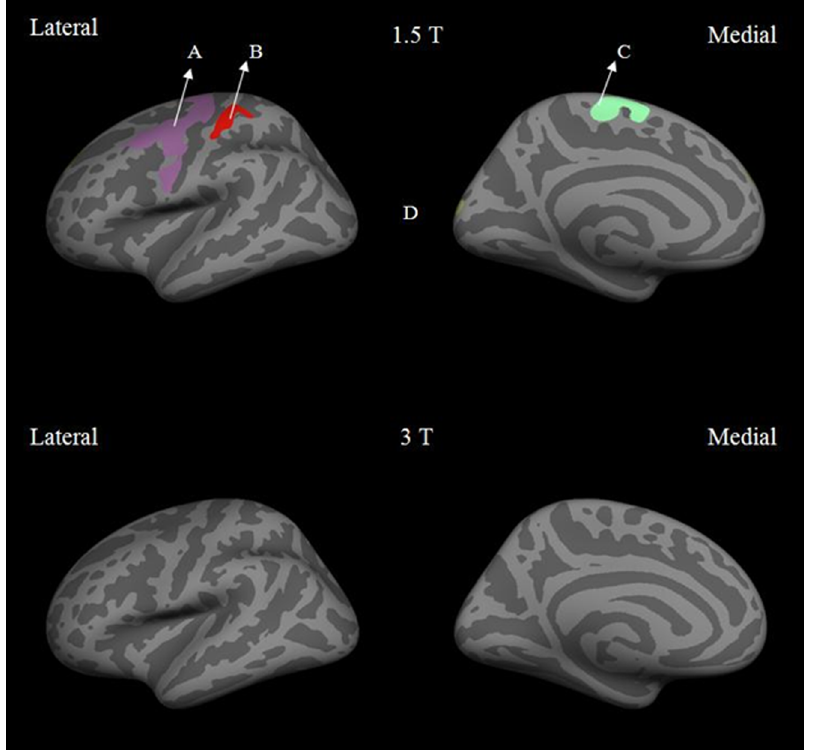
Figure 2. Lateral and medial views of inflated left hemisphere at 1.5 T and 3 T for male vs. female differences in cortical thickness. The labeled regions are: (A) precentral, (B) postcentral, (C) paracentral and (D) lateral occipital